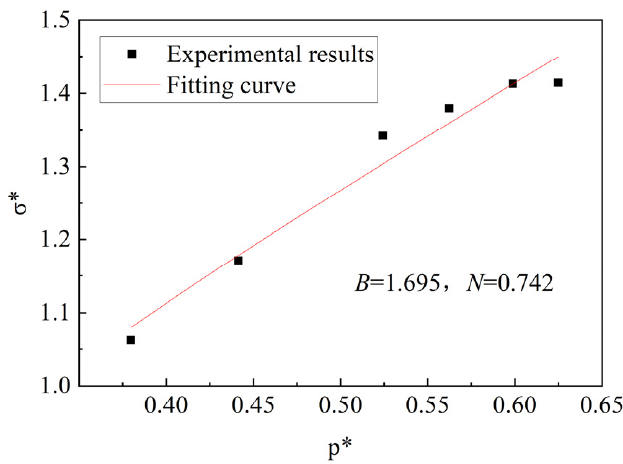
Figure 3. Technique for determining strength constants B and N.